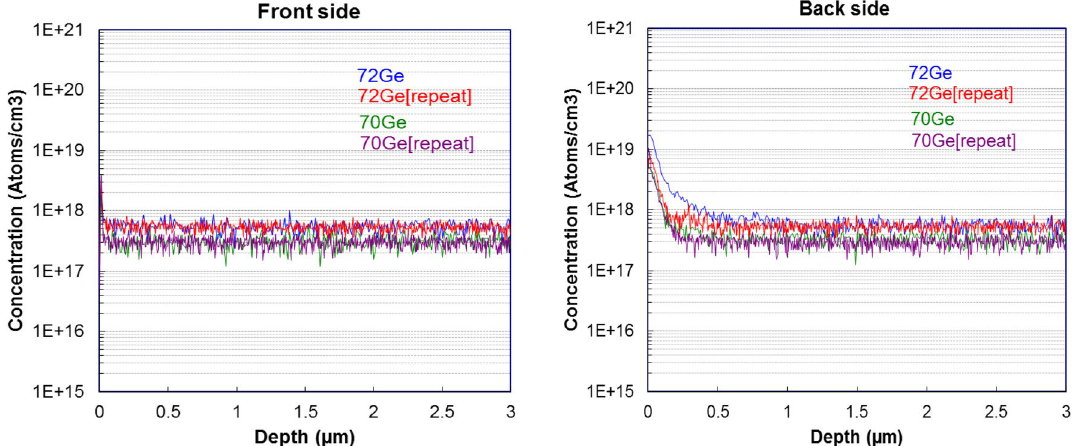
Figure 3. SIMS data showing consistent doping concentration of both 70 Ge and 72 Ge in a 10 18 doped GaN